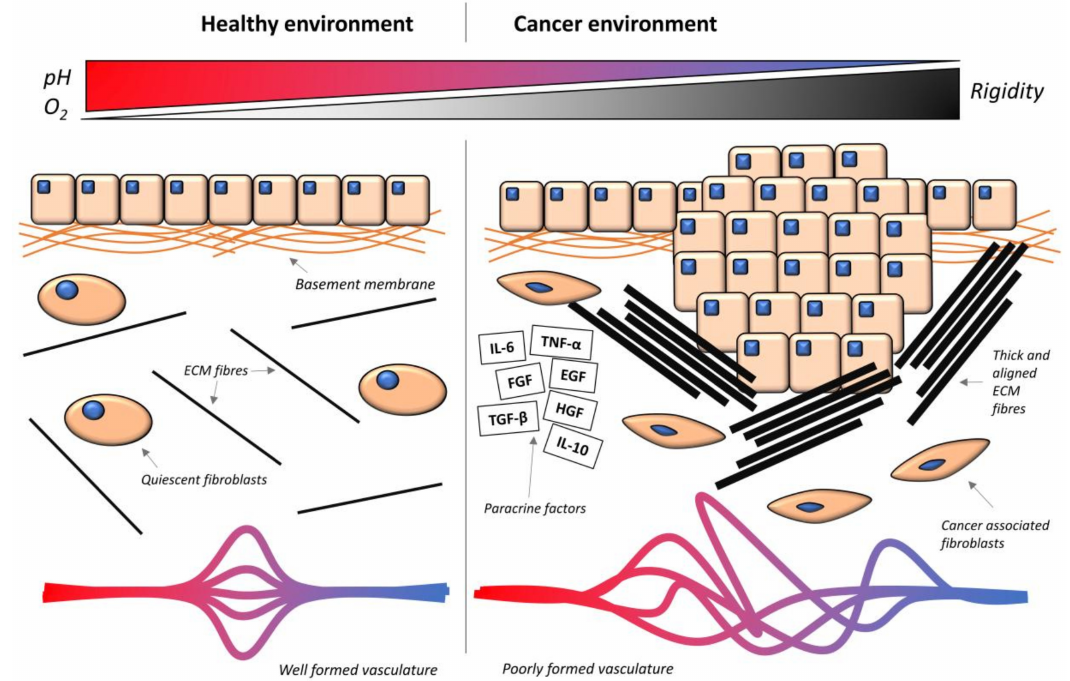
Figure 2. Comparison between the healthy and the cancer microenvironment. In the healthy environment, epithelial cells are separated from the stroma below by the basement membrane. In the stroma, fibroblasts show their quiescent phenotype, and there is a low abundance of ECM fibers (black), and therefore reduced rigidity. The vasculature is highly organized, and there is a high level of oxygen and a neutral pH. In the cancer environment, excess cell growth leads to breaching of the basement membrane, and cells are in contact with the stroma. Cancer-associated fibroblasts (CAFs) become activated, and there is a high abundance of ECM fibers and growth factors (black outlined rectangles). TNF- α = tumor necrosis factor alpha, IL-6 = interleukin 6, IL-10 = interleukin 10, EGF = epidermal growth factor, FGF = fibroblast growth factor, HGF = hepatic growth factor, TGF- β = transforming growth factor beta. The vasculature is excessive but poorly organized, and oxygen and pH are reduced. Stromal rigidity is